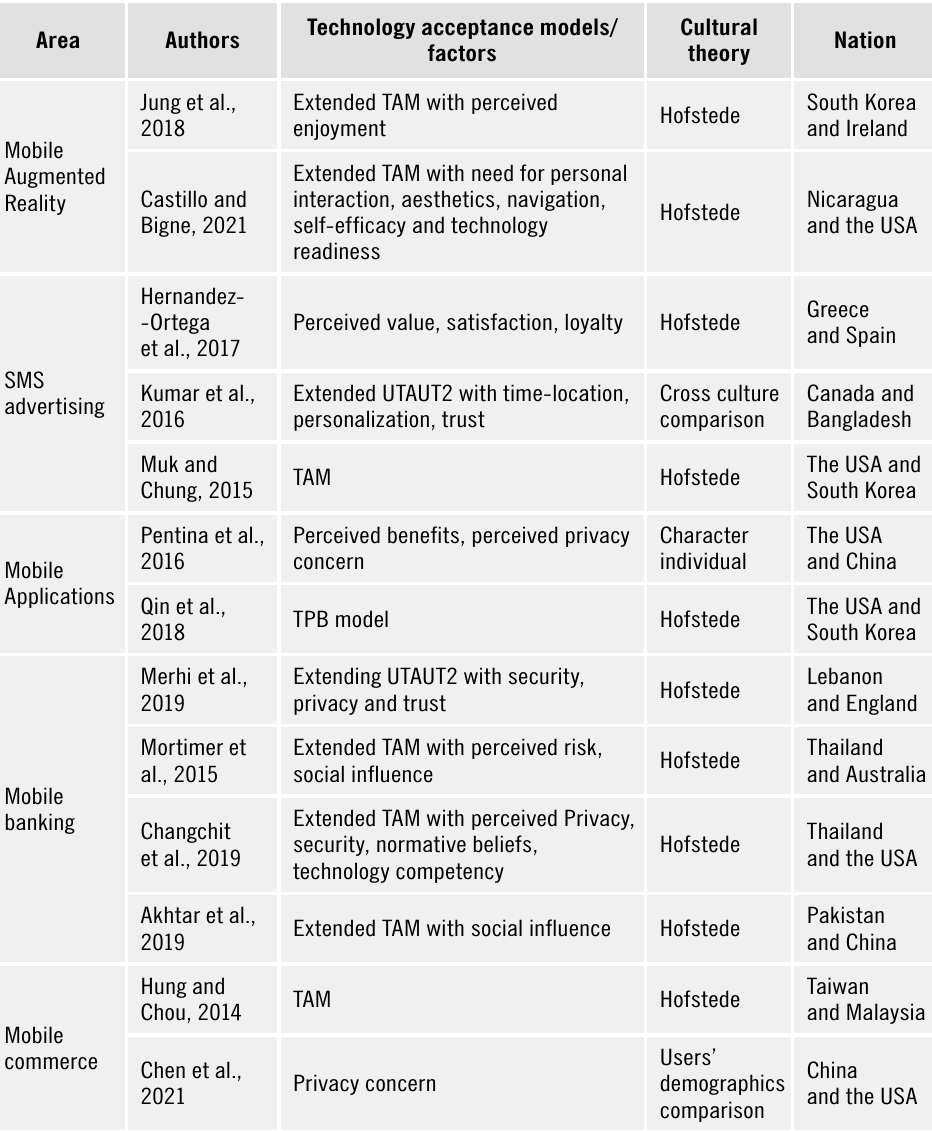
Table 3. Cross-culture studies in the mobile marketing context